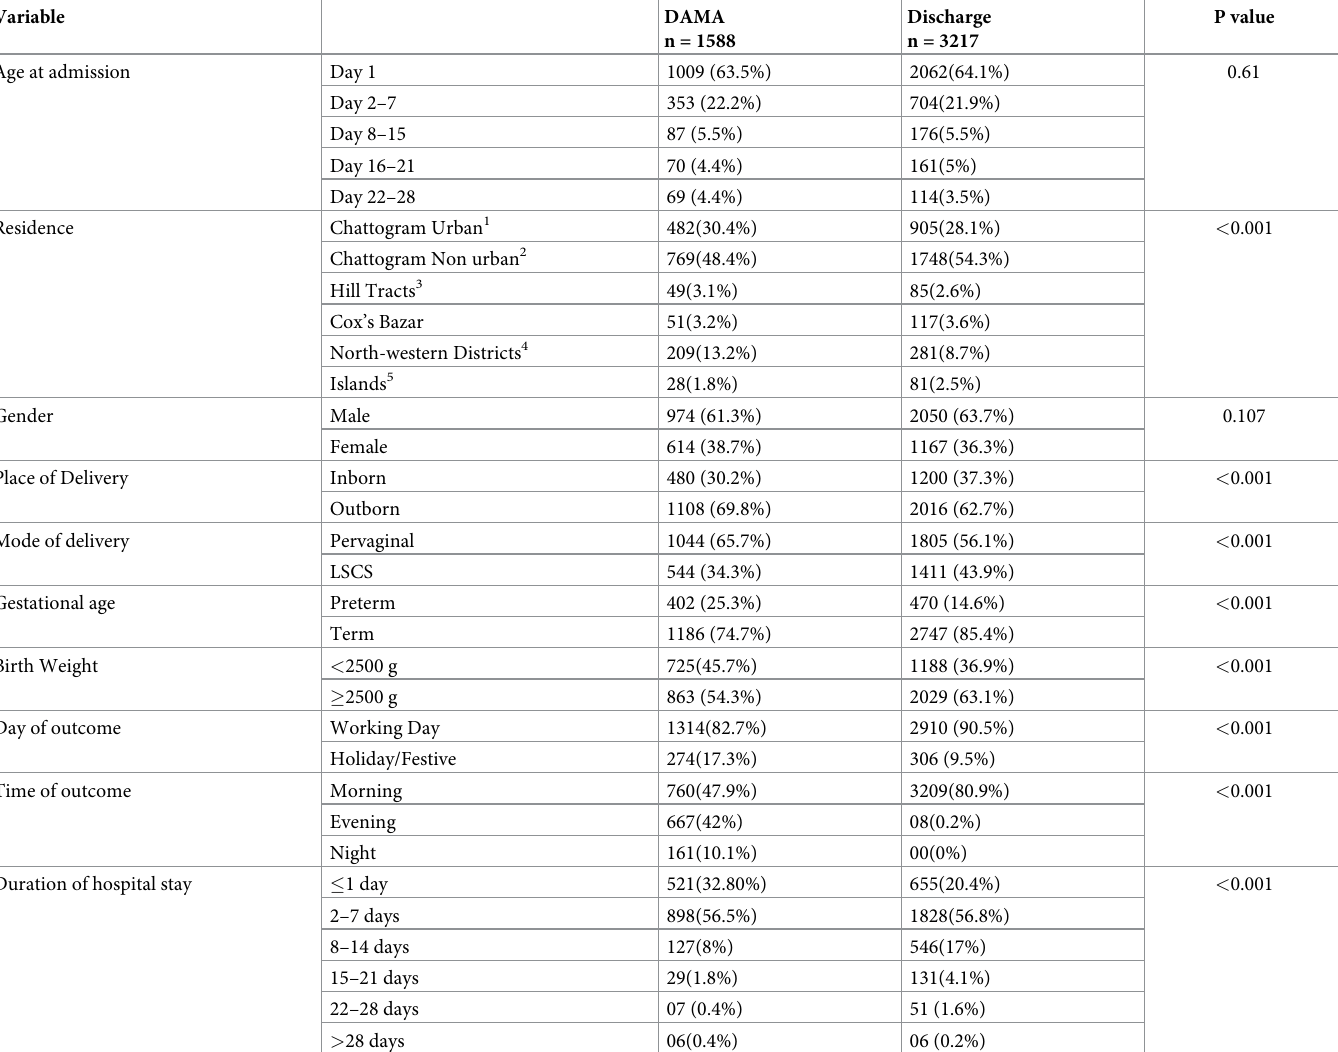
Table 1. Demographic profile of neonates DAMA and discharge with medical